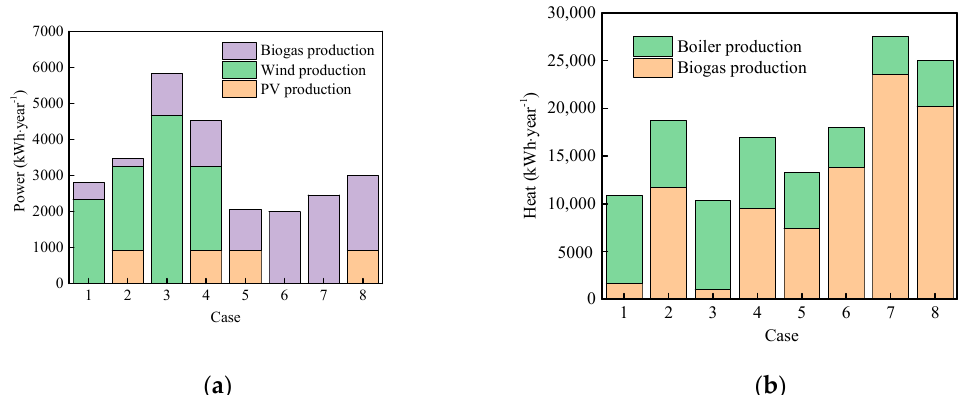
Figure 9. Computed generation profiles (0.5 kW wind turbine, PV and biogas genset): ( a ) power and ( b ) heat.